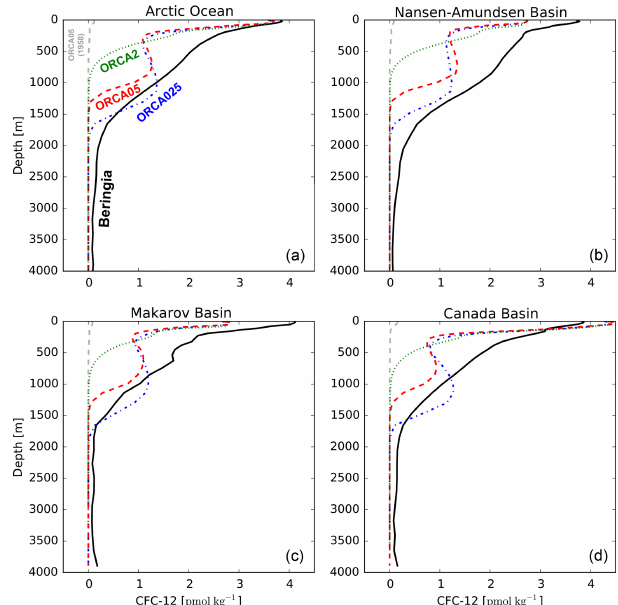
Figure 5. Profiles of observed CFC-12 (black solid) and simu- lated CFC-12 in ORCA2 (green dots), ORCA05 (red dashes), and ORCA025 (blue dot–dash) along the Beringia 2005 section. Shown are distance-weighted means across that entire section (a) as well as over that section covering the Nansen and Amundsen basins (b) , the Makarov Basin (c) , and the Canada Basin (d) . Shown in light grey is the vertical profile in 1958, the branching point for the three